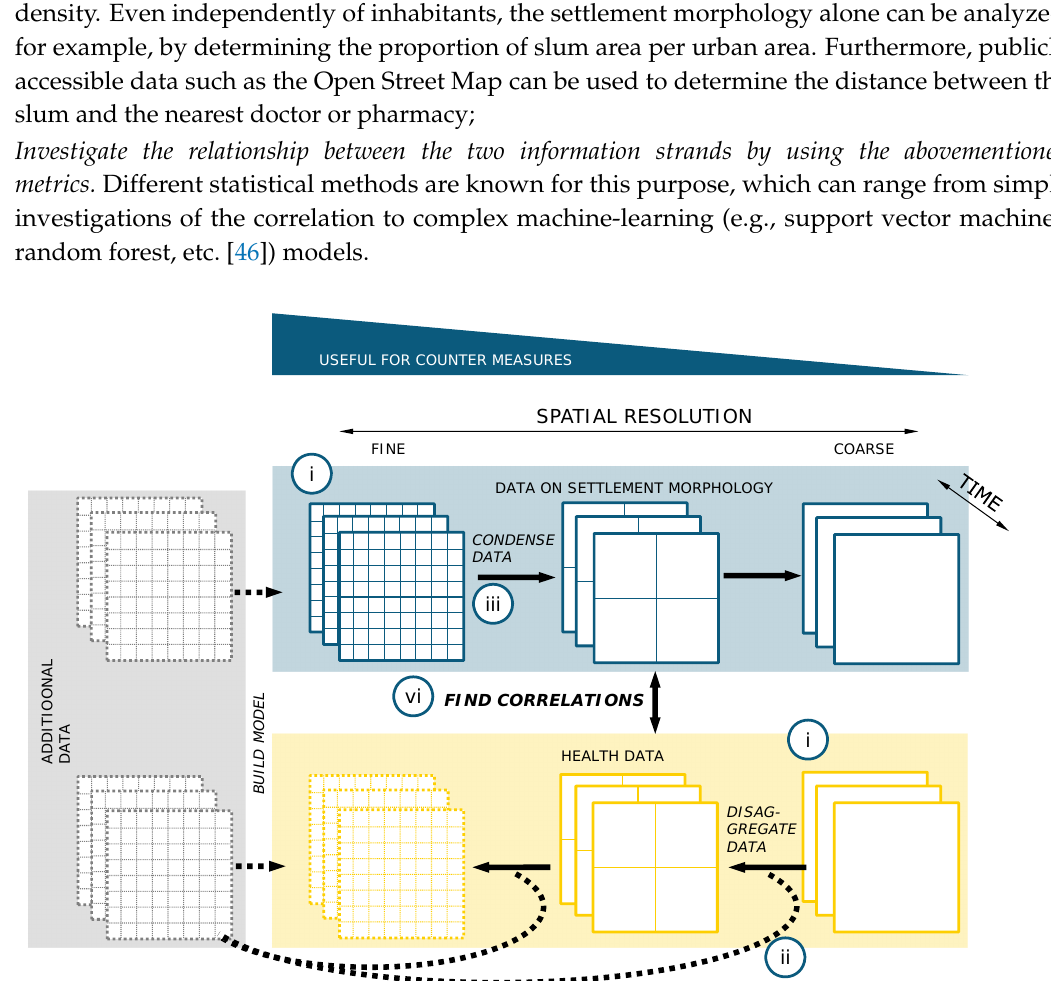
Figure 7. Framework to investigate correlations between settlement (blue box) and health data (yellow box). Furthermore, it is possible to enrich the different settlement and health data with additional data to increase the resolution of the datasets. Examples of additional data are described in the text. Only three spatial resolutions are shown representatively, of course an unlimited number of intermediate levels is possible. The numbering in the blue circles shown in the figure is explained in detail in the